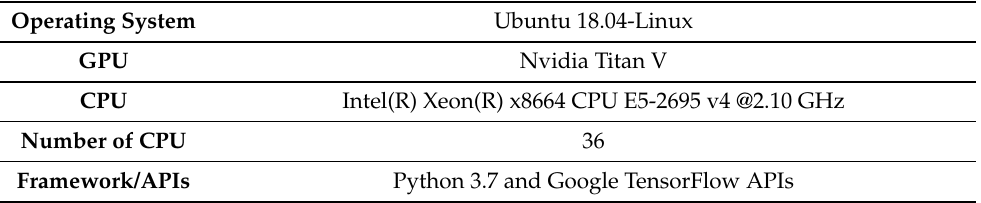
Table 11. Experiments A.3 and B.1 Environment Setup